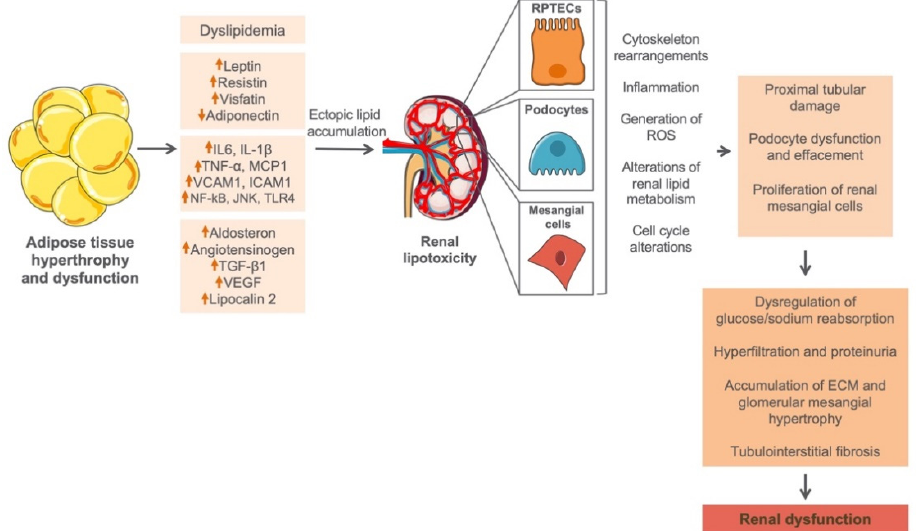
Figure 2. Effects of adiposity on normal renal function. Abnormal hypertrophy of adipose tissue in obesity may lead to changes in expression of different adipocytokines, inflammatory and profibrotic parameters, as well as the ectopic accumulation of circulating lipids in the kidney, contributing to tissue damage through a process known as lipotoxicity. RPTECs, podocytes, and mesangial cells are not equipped with an adequate machinery to handle large lipid overloads; thus, accumulation of lipids in these cells will lead to a cell dysfunction accompanied by the generation of ROS, impairment of renin–angiotensin–aldosterone activity, secretion of proinflammatory and profibrotic factors, and insulin resistance. These self-perpetuating secondary events may subsequently lead to a further damage of renal cells and progressive impairment of kidney structure and function. RPTECs, renal proximal tubular epithelial cells; ROS, reactive oxygen species; ECM, extracellular matrix